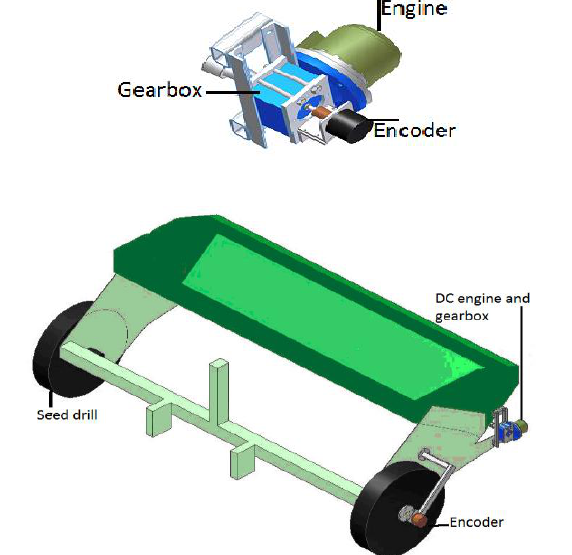
Figure 7 - Changing the rotational speed of seed metering drive shaft using the DC engine and gearbox with a constant gear